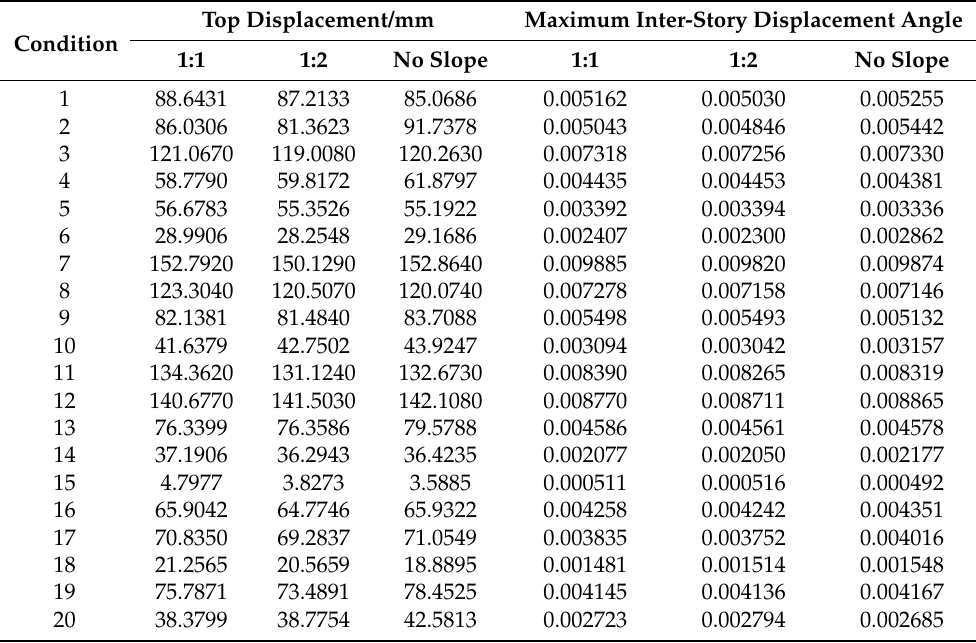
Table 5 indicates the peak displacement of the top floor and the maximum inter-story displacement angle of the structure under the action of 20 seismic waves. Table 5. Crest value of displacement of top floor and maximum inter-story displacement